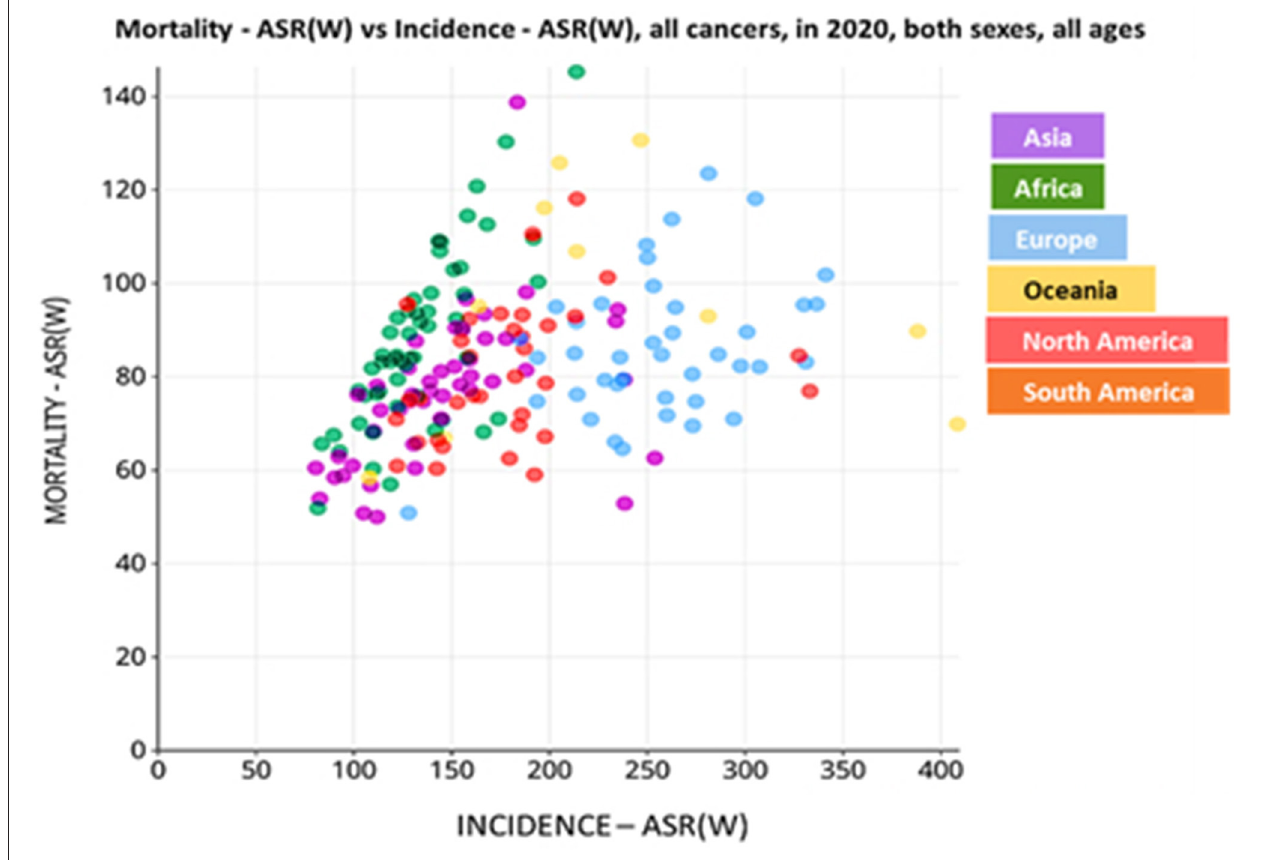
FIGURE 1 | Incidence of cancer-related deaths in the different continents, per 100,000 population. Data is based on the incidence vs. mortality rate of cancer patients in the year 2020. World age-standardized rate [ASR (W)]. Data source: Globocan 2020; World Health Organization (WHO)